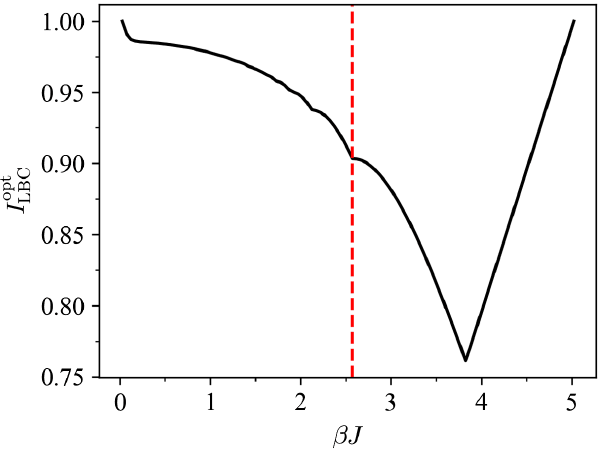
FIG. 19. Optimal indicator of LBC for the IGT ( L ¼ 12 ) with dimensionless inverse temperature p ¼ β J as a tuning parameter, 5 , and Δ p ¼ 0 . 05 . The critical value of where p 1 ¼ 0 . 05 , p K ¼ β J from Fig. 4 is highlighted in the tuning parameter p c ¼ c